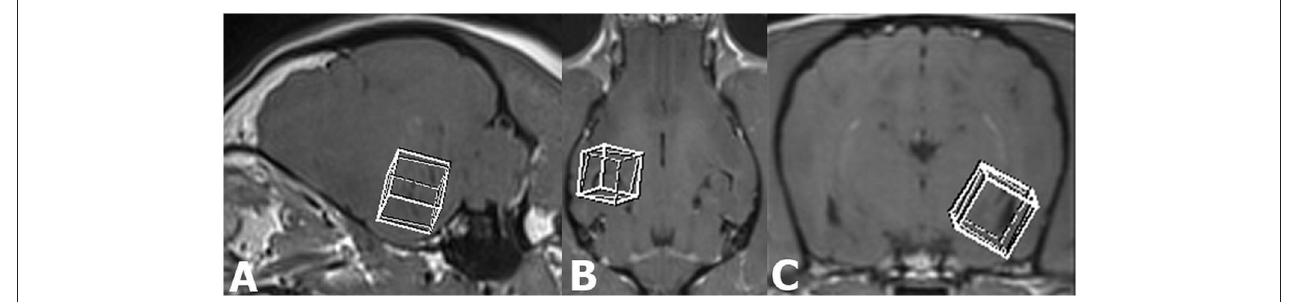
FIGURE 1 | Sagittal (A) , dorsal (B) , and transverse ( C ) T1-weighted MR images illustrating the voxel placement in the temporal lobe including the hippocampus and part of the